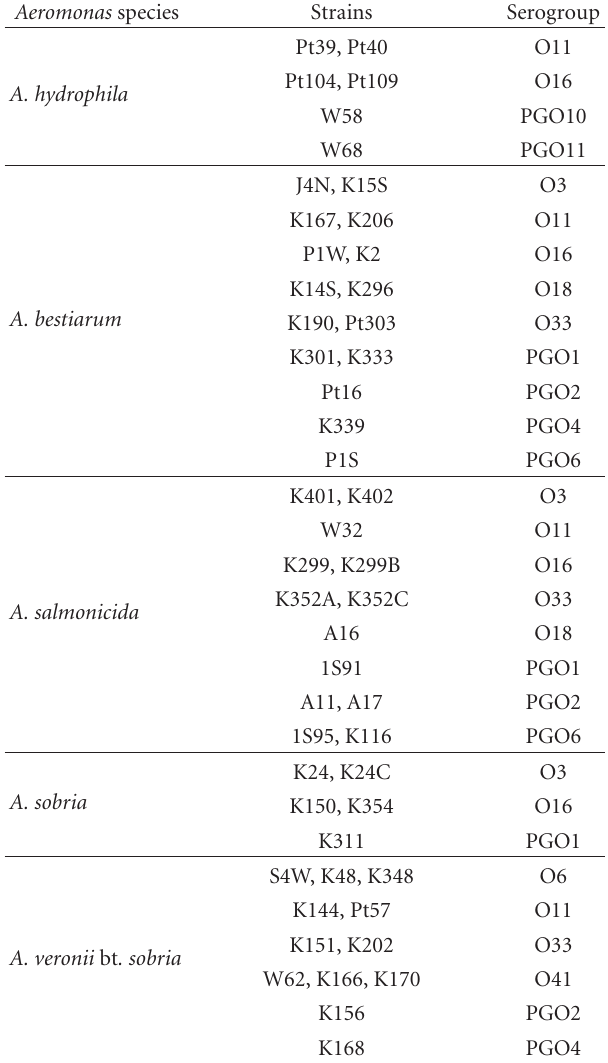
Table 1: Aeromonas strains used for challenge